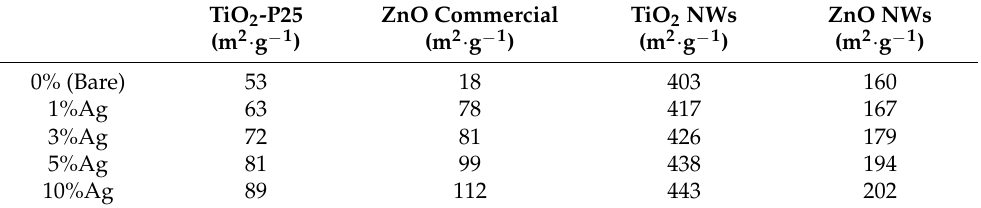
Figure 3. X-ray diffraction patterns (XRD) of TiO 2 NW ( A ,a), 10%Ag@TiO 2 NW ( A ,b), TiO 2 -P25 ( B ,c), 10%Ag@TiO 2 -P25 ( B ,d), ZnO commercial ( C ,e), 10%Ag@ZnO commercial ( C ,f), ZnO NW ( D ,g), and 10%Ag@ZnO NW ( D ,h) catalysts. Table 1. Brunauer, Emmett and Teller (BET) surface area of the silver-based